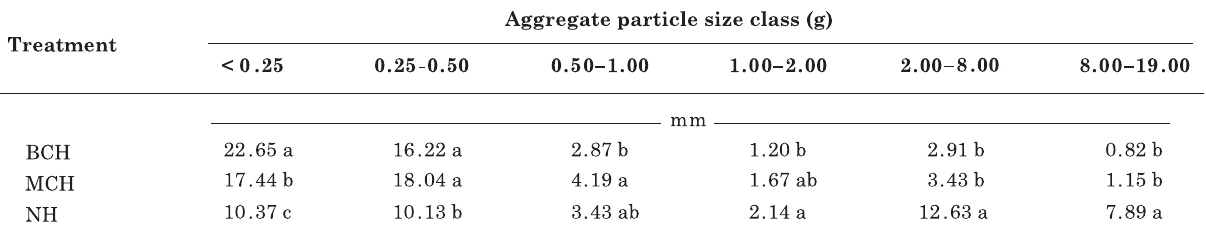
Values followed by different letters indicate significant differences in the Tukey test at 5 %.